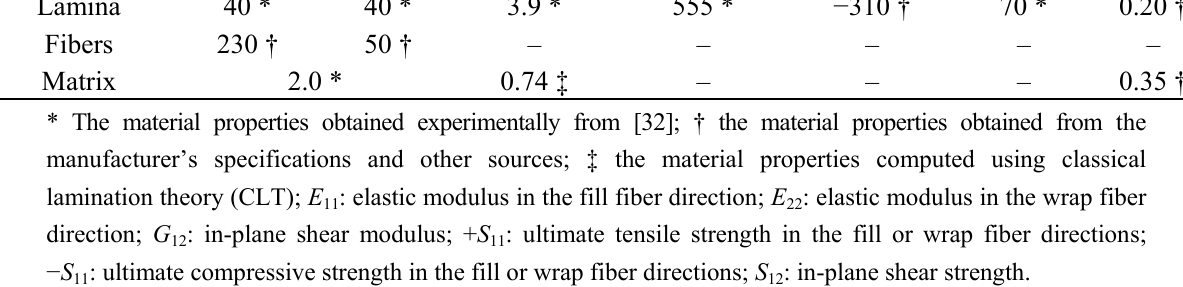
, GPa E , GPa G , GPa + S , MPa − S , MPa 11 22 12 11 11 40